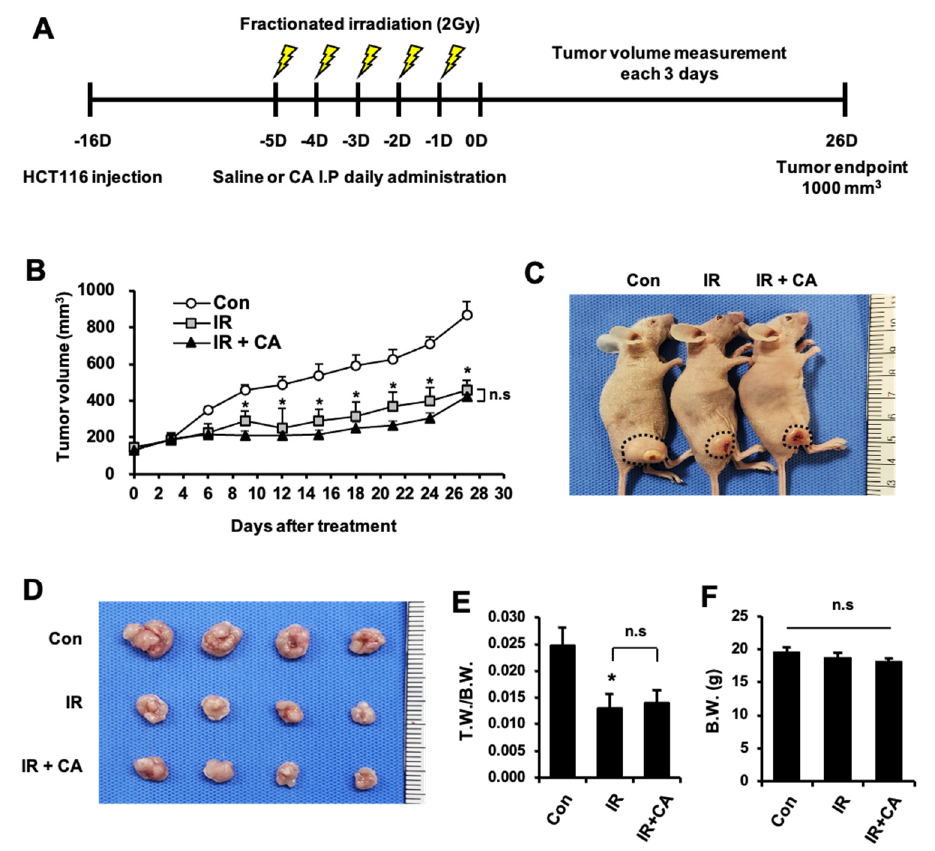
Figure 8. Centella asiatica treatment does not occur the radioprotective effect on colorectal tumor growth. Groups of tumor-bearing are as follows: control (Con), local irradiated (IR), local irradiated mouse administrated with Centella asiatica (IR + CA). ( A ) Scheme of the experimental procedure. Tumor-bearing mice were irradiated with g-rays (2 Gy × 5 fractionations for 5 days) followed by CA administration. Treatments began when tumor volume reached 100 mm 3 . ( B ) Tumor growth curves of the HCT-116 xenograft model after IR or IR plus CA treatment were determined. Representative images of ( C ) the tumor-bearing mice and ( D ) the excised tumor mass. ( E ) Tumor weight (T.W.) and body weight (B.W.) ratio was examined after mice were sacrificed. ( F ) B.W. of mice were examined. Data are presented as the mean ± standard error of the mean; n = 7 mice per group. * p < 0.05 compared to the Con group. “n.s” indicates not significant ( p > 0.05). All data represent at least